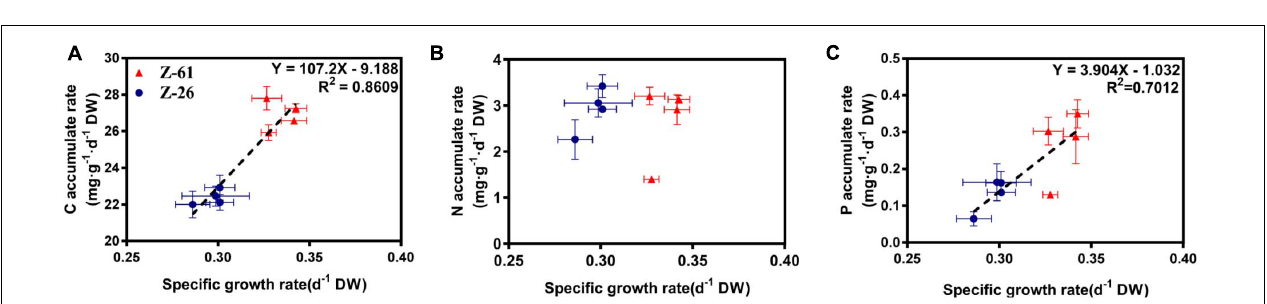
FIGURE 2 | Tissue nutrient contents of the Z-61 (A) and Z-26 (B) exposed to the different nutrient treatments. C (carbon), N (nitrogen), and P (phosphorus) contents expressed as percent of sample dry weight (DW). All data are expressed as mean ± SD ( n = 4), and different letters represent significant differences ( P < 0.05) among the treatments.